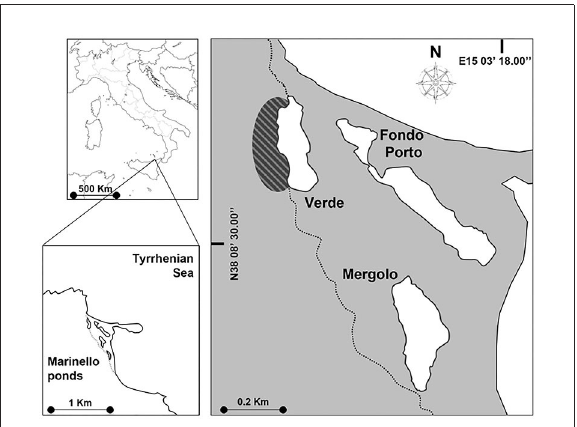
FIGURE1 Map of the Marinello coastal system. The ponds studied were Verde (VE), Mergolo (ME), and Fondo Porto (FP) at increasing distance from the gull colony indicated by the striped oval. The dotted line indicates the edge of the Tindari promontory.